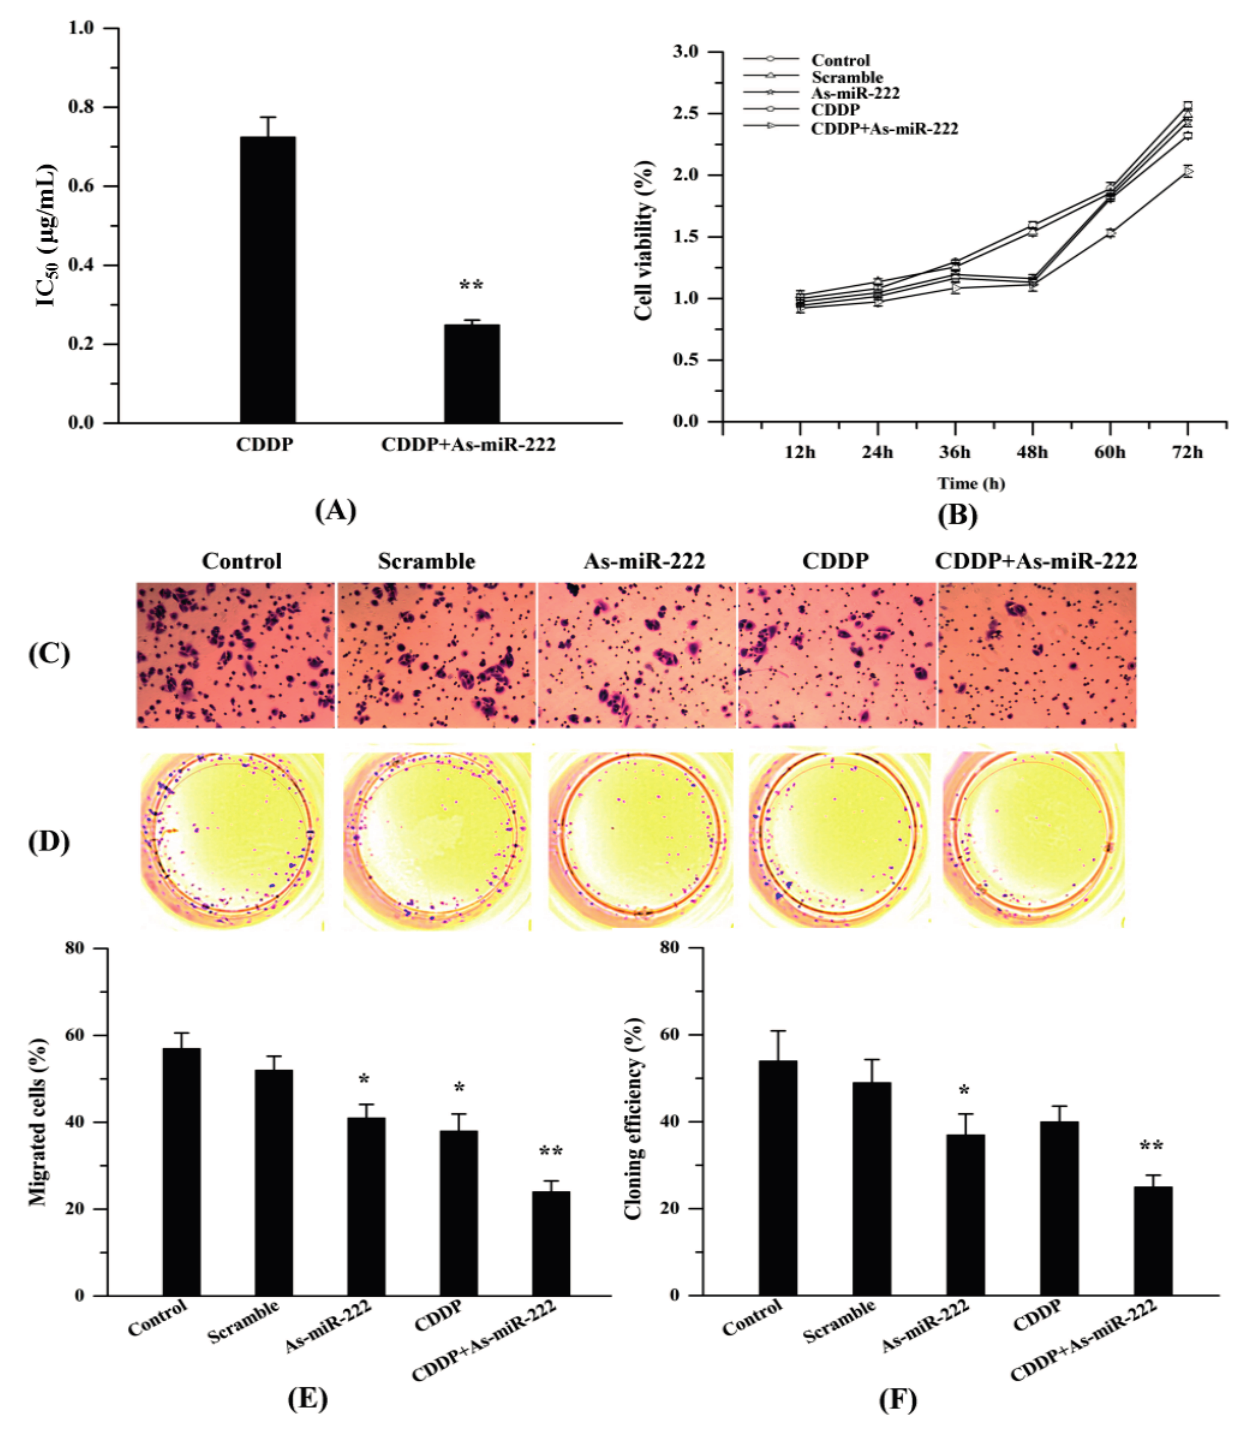
Figure 4. Effect of As-miR-222 on the chemosensitivity of UM1 cells to CDDP treatment and on cell proliferation and invasion. ( A ) IC 50 of UM1 cells treated with CDDP alone or in combination with As-miR-222; ( B ) MTT assay was performed to detect the growth of UM1 cells treated with As-miR-222 and CDDP; ( C , E ) Cell migration was detected by a transwell assay; and ( D , F ) Cell-clone-forming experiments were used to detect cell proliferation. * Denotes statistical significance ( p < 0.05); ** denotes obvious statistical significance ( p <